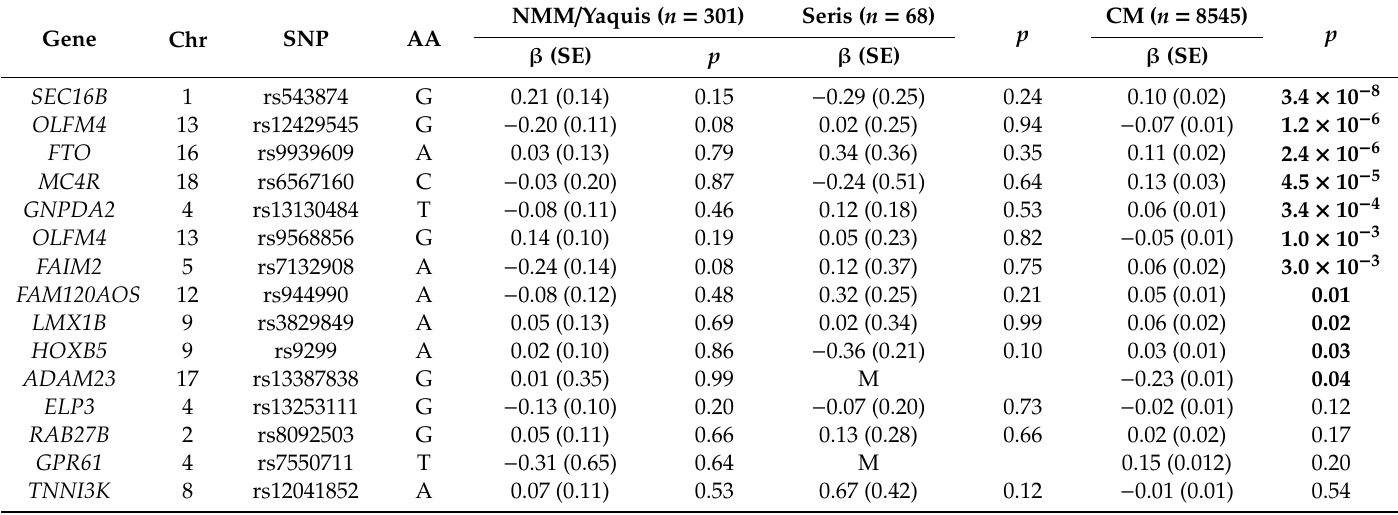
Table 2. Results of association analysis with body mass index (BMI) in Northern Mexican Mestizo (NMM) / Yaqui, Seri and Central Mexican (CM) children. Significant associations are shown in bolds. Chromosome (Chr), Associated allele (AA), estimate ( β ), standard errors (SE), p -value ( p ), monomorphic